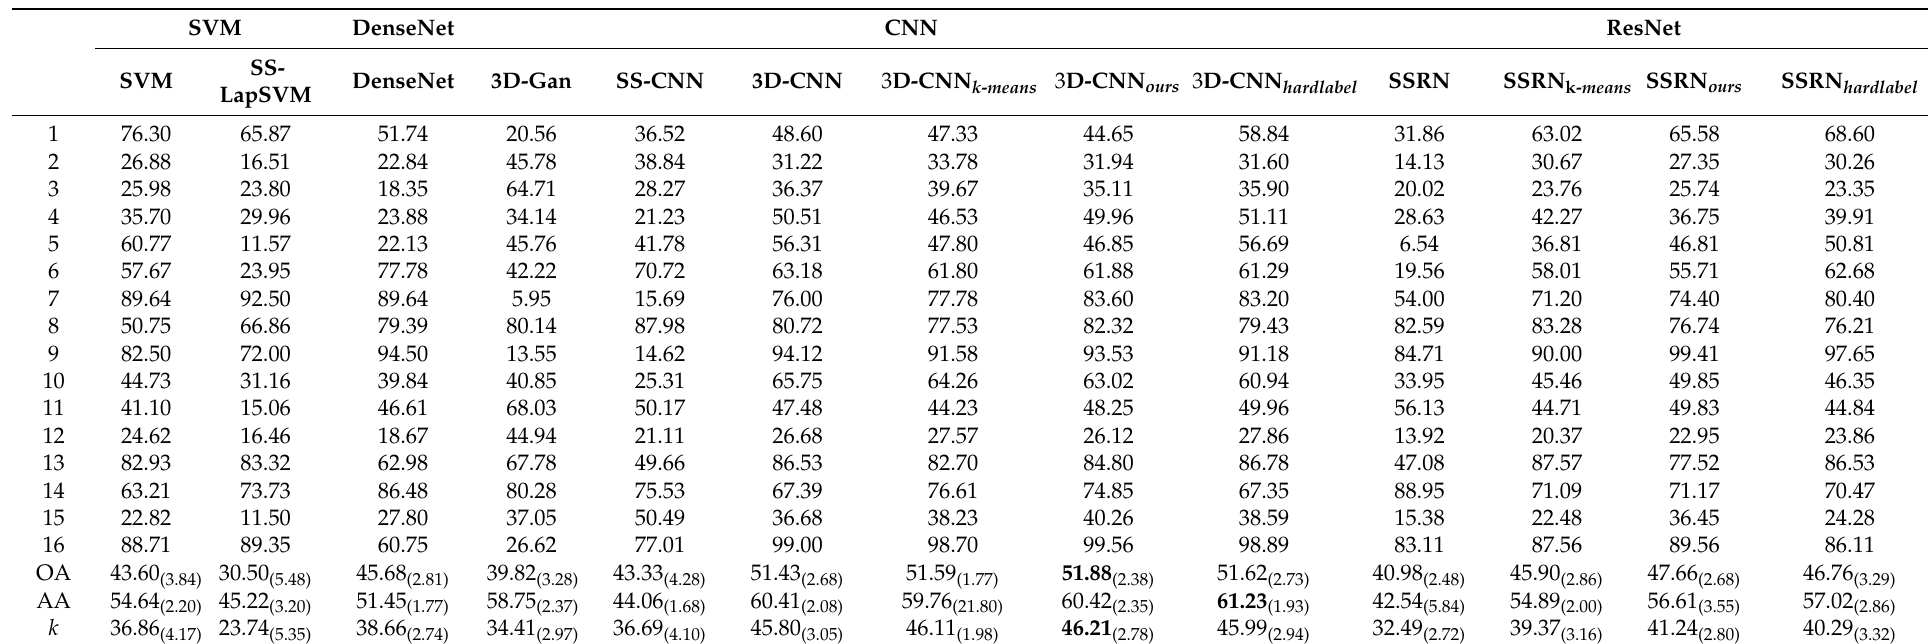
Table 6. Classification accuracy (%) for all methods with three training samples on the Indian Pines